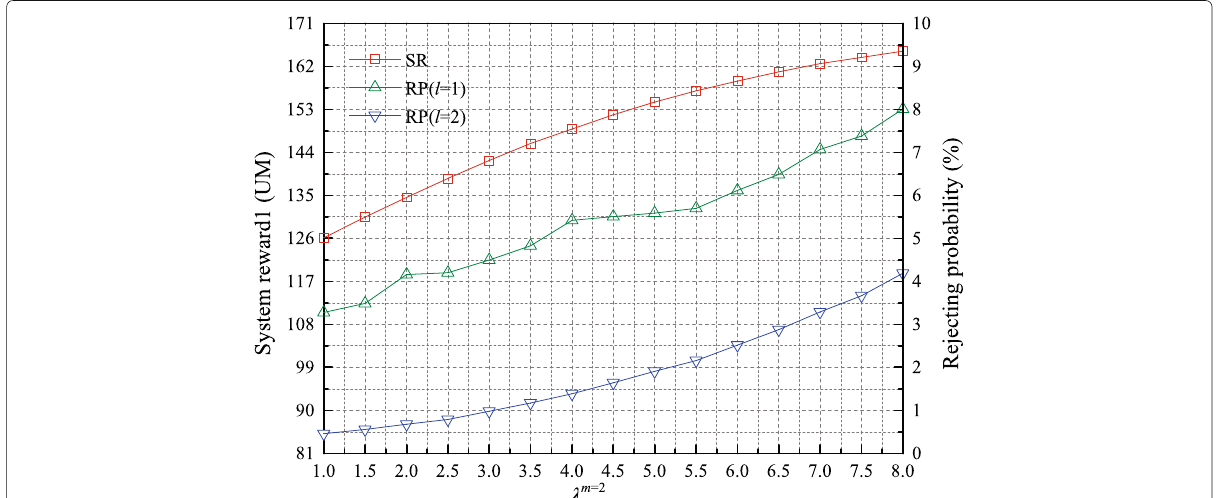
Fig. 10 SR and RPs under different arrival rates of the 2-class task request. This figure shows the evaluation results under different arrival rates of the 2-class task request. Figures 9 and 10 show the evaluation results under different arrival rates of the m -class task request